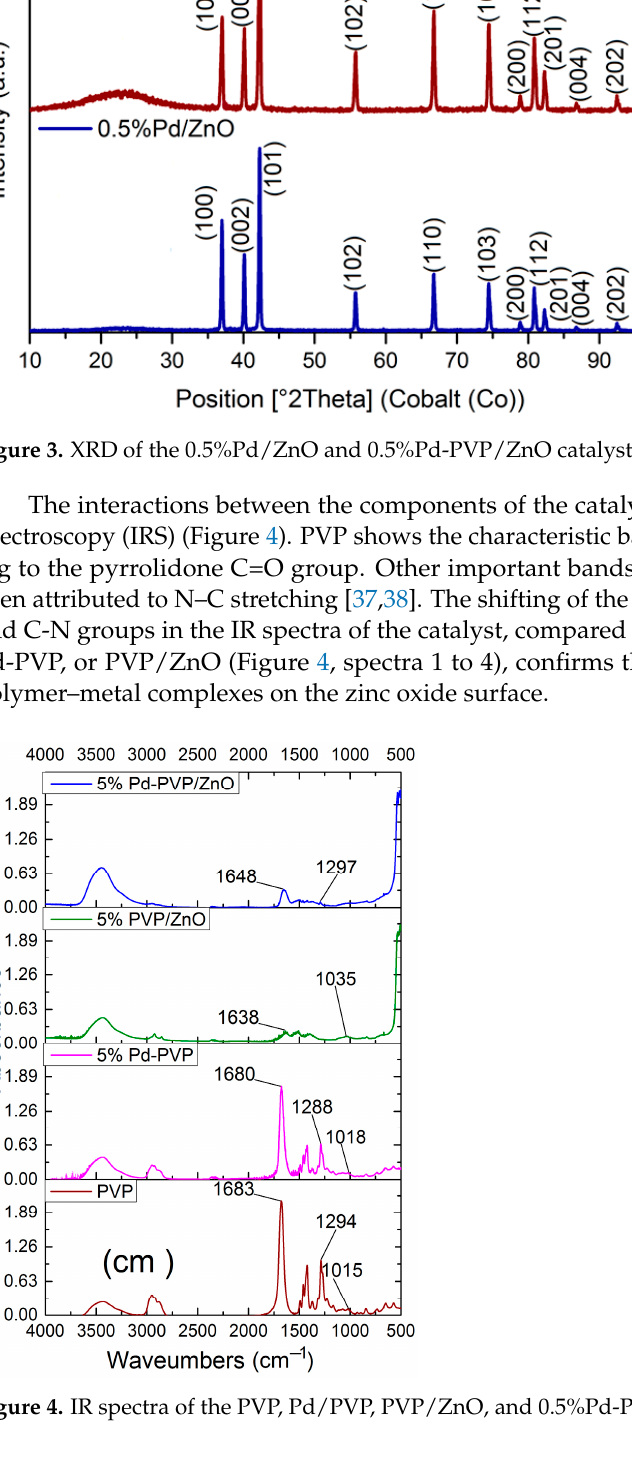
( a ) ( b ) Figure 5. TEM images of the 1%Pd/ZnO ( a ) and 1%Pd-PVP/ZnO ( b ) catalysts and the Pd particle size distribution. At first sight, nanoparticles seem to be near the same size in both samples. However, a more detailed analysis of the TEM images showed that the PVP-modified catalyst